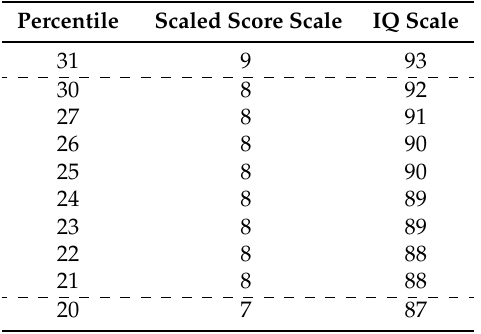
Table 3. Score conversion